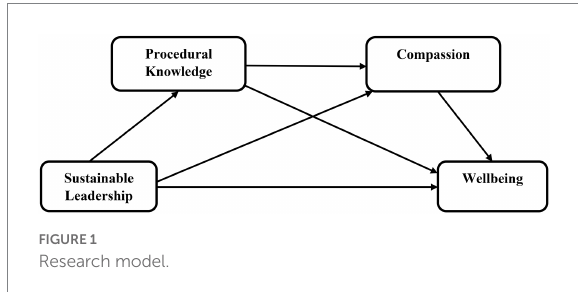
FIGURE 1 Research